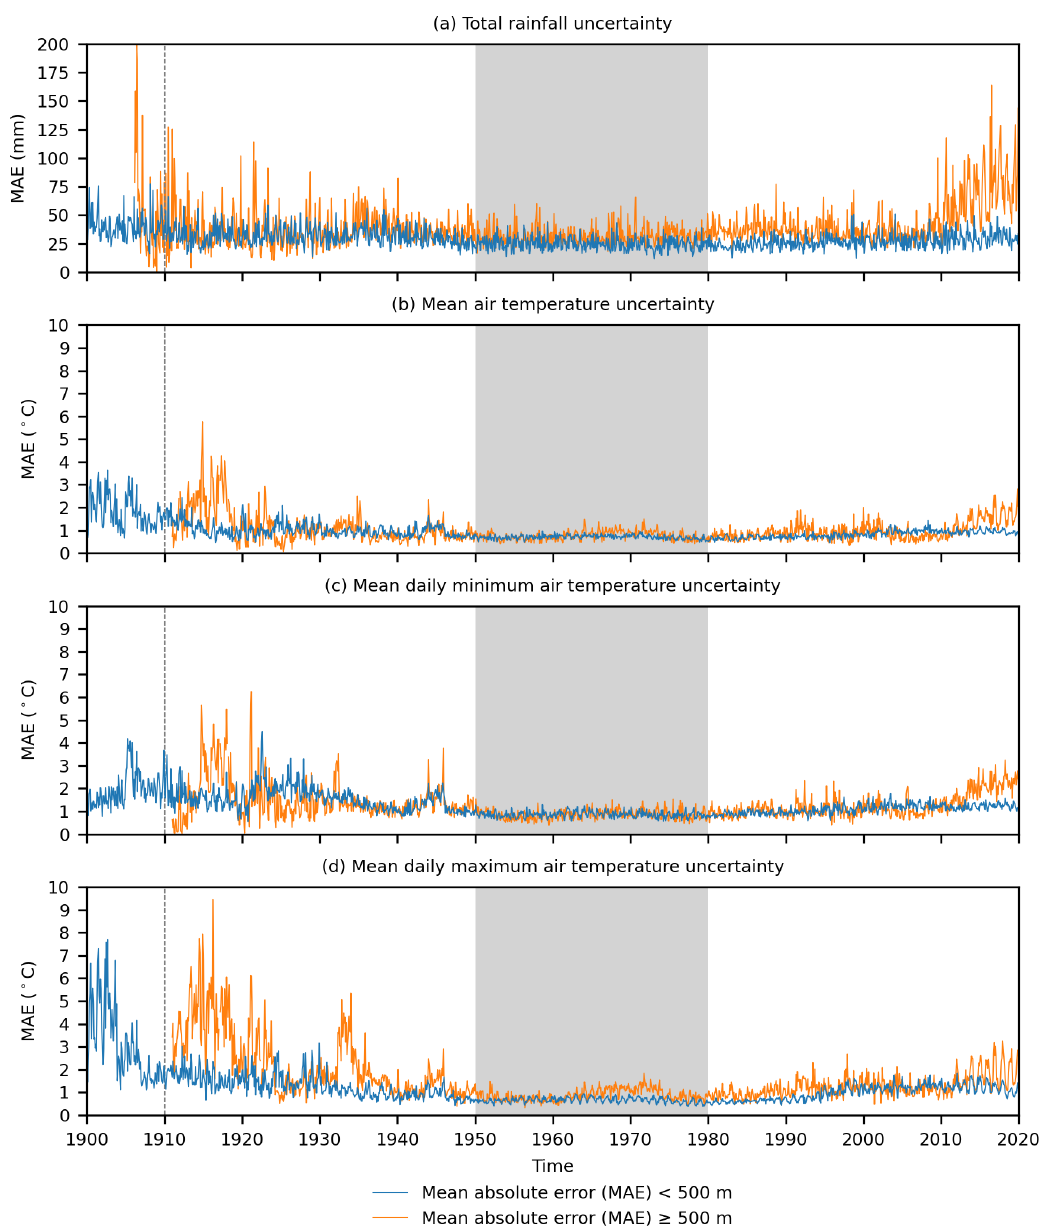
Figure 7. Monthly time series of the cross-validated mean absolute error (MAE) of climatologically aided natural neighbour uncertainty across New Zealand at < 500m elevation and ≥ 500m elevation for (a) total rainfall (mm), (b) mean air temperature ( ◦ C), (c) mean daily minimum air temperature ( ◦ C), and (d) mean daily maximum air temperature ( ◦ C). The grey areas show the period (1950–1980) over which the climatologies used to aid interpolation apply, and the dashed lines indicate the temporal limit of reliable